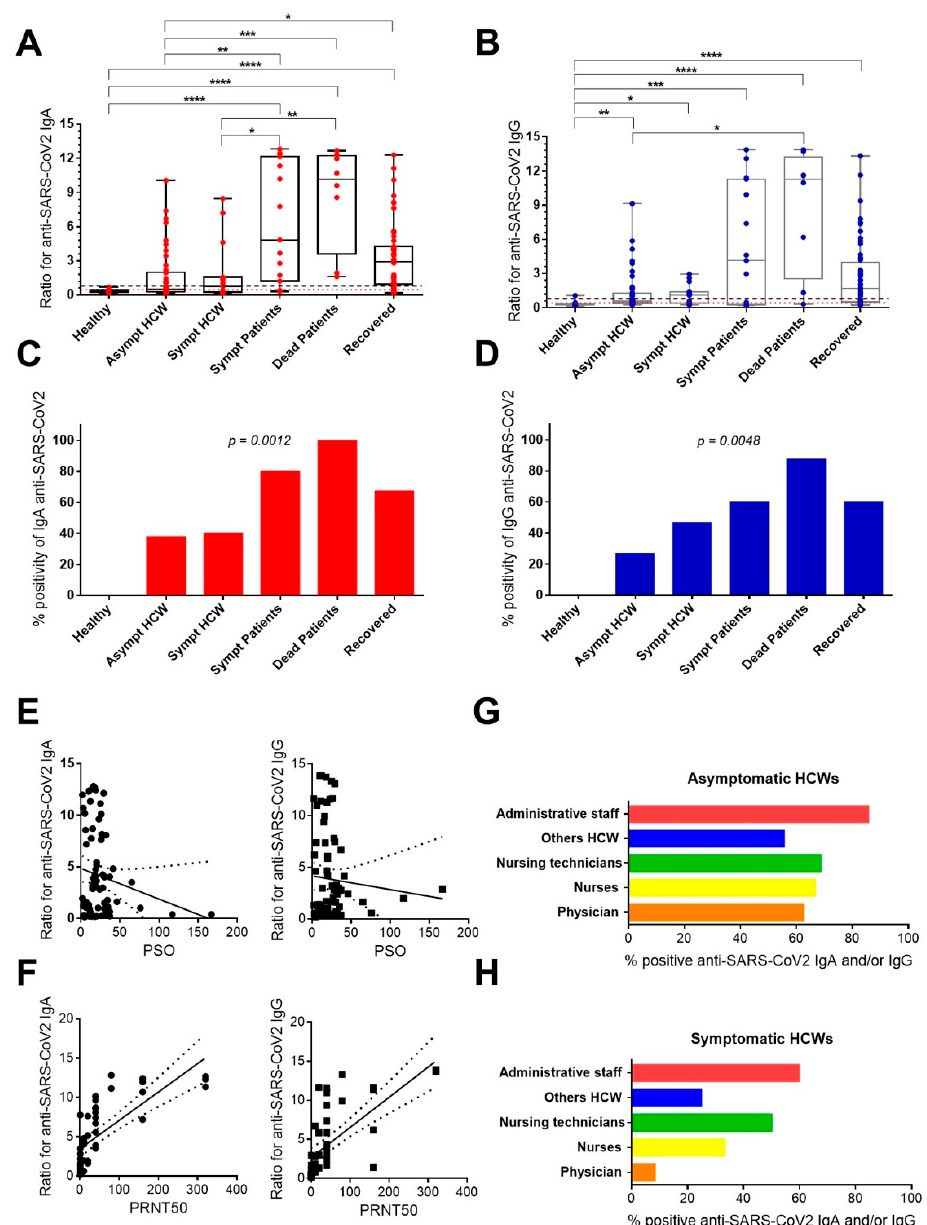
Figure 1. IgA and IgG seropositivity in HCWs and COVID-19 Patients exposed and/or infected to SARS-CoV-2 during the pandemic. According to the manufacturer’s instructions, the results are expressed by calculating the ratio of the absorbance value of the control or patient sample to the absorbance value of the calibrator. ( A ) Comparison of specific IgA and ( B ) IgG ratios in non-COVID- 19 healthy individuals (n = 17), asymptomatic HCWs (n = 44), acute symptomatic HCWs (n = 15), acute symptomatic COVID-19 patients (n = 15), COVID-19 patients who died (n = 8) and patients recovered from COVID-19 (n = 52). The box plots show the median (middle line), and the whiskers show minimum to maximum quartiles above and below the box. Dashed black line represents cutoff for positivity (ratio ≥ 1.1). Dotted red line corresponds to cutoff for negativity (ratio < 0.8). The p values were calculated using the Kruskal–Wallis test followed by Dunn’s multiple comparisons test. ( C ) Changes to seropositivity rates for specific IgA and ( D ) IgG among groups. ( E ) Spearman correlation test was applied on the data means of PRNT 50 for detection of SARS-CoV-2-neutralizing antibodies with the days of post-symptoms onset (PSO) and ( F ) with anti-SARS-CoV-2 IgA and IgG ratios. ( G ) Percentage of seropositivity (IgA and/or IgG) among asymptomatic HCWs physician (n = 12), nurses (n = 6), nursing technicians (n = 12), other HCWs (n = 4) and administrative staff (n